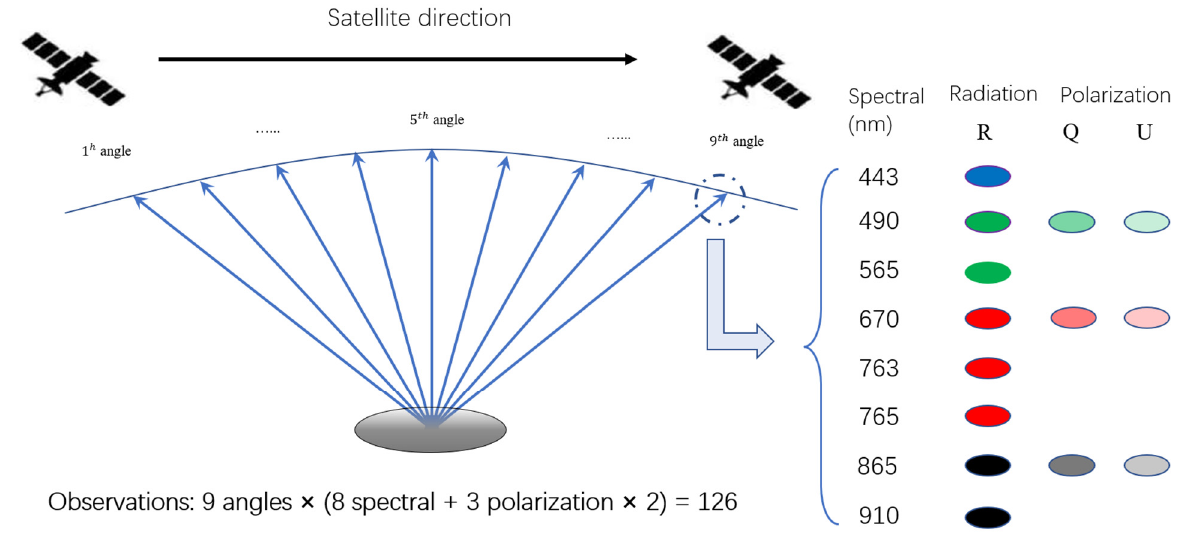
Figure 1. The multi-angle observation principle and the description of the measurement dataset of DPC.